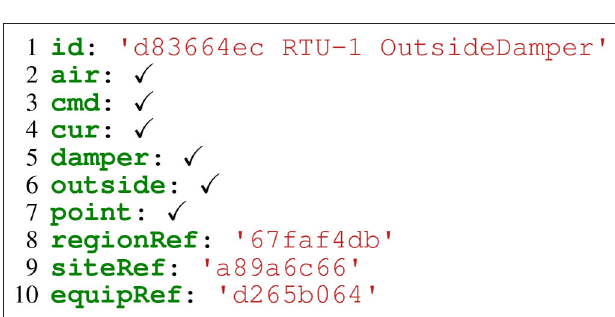
FIGURE 6 | Original Haystack entity from the Carytown reference